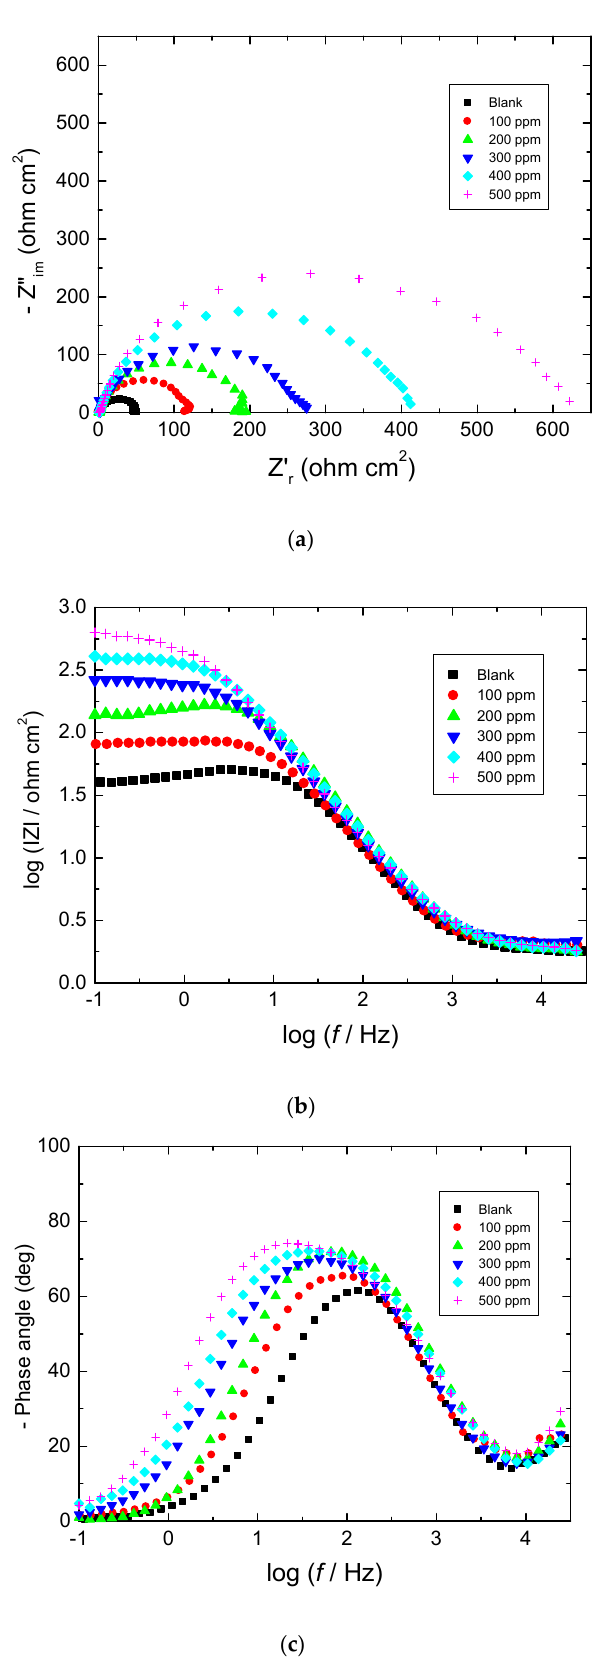
Figure 5. Plots of: ( a ) Nyquist, ( b ) Bode magnitude, and ( c ) Bode phase for mild steel in 0.5 M HCl solution at 303 K in absence and presence of pectin.